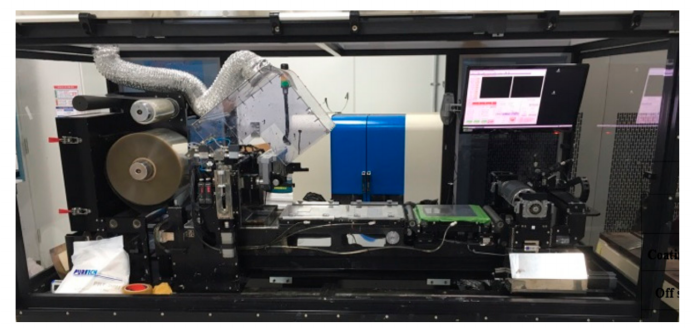
Figure 4. Reverse offset printing equipment used in this